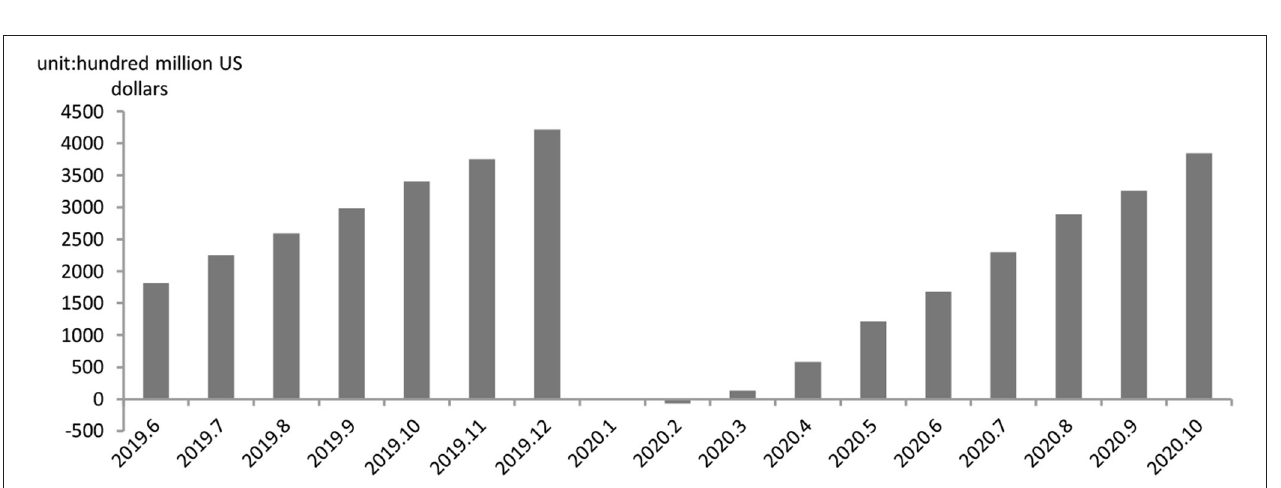
FIGURE 6 | Cumulative value of China’s import and export balance. Data source: National Bureau of statistics of the People’s Republic of